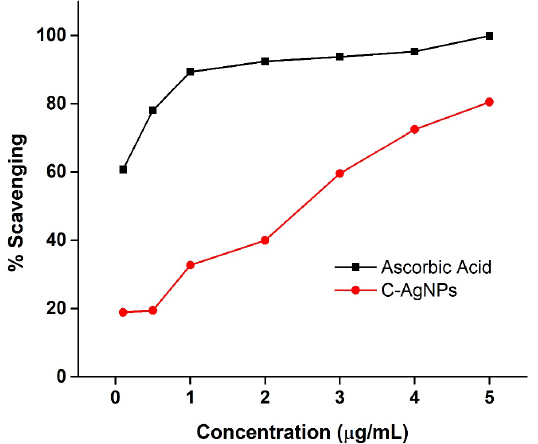
Figure 12. Comparison of antioxidant activity of ascorbic acid and C-AgNPs by DPPH assay.